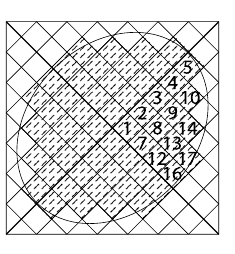
Figure 1. Pixeled metasurface inclined by an